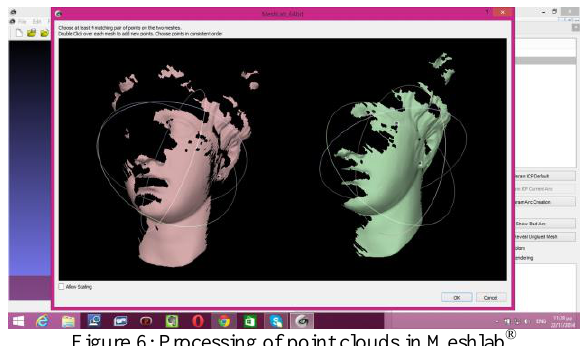
Figure 6: Processing of point clouds in Meshlab